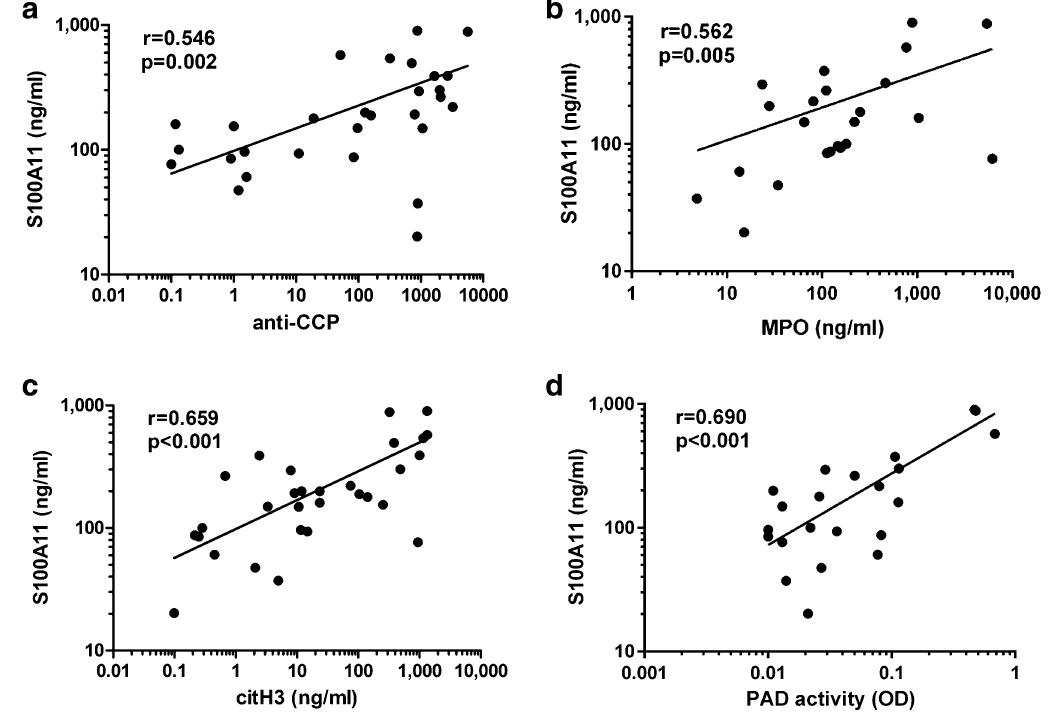
Figure 2. The synovial fluid levels of S100A11 significantly correlate with the levels of anti-CCP in the synovial fluid of RA patients ( a ). S100A11 is associated with the levels of myeloperoxidase (MPO) ( b ), citrullinated histone 3 (citH3) ( c ) and with the activity of peptidyl-arginine deiminase (PAD) enzymes ( d ) in the synovial fluid of patients with RA (n =